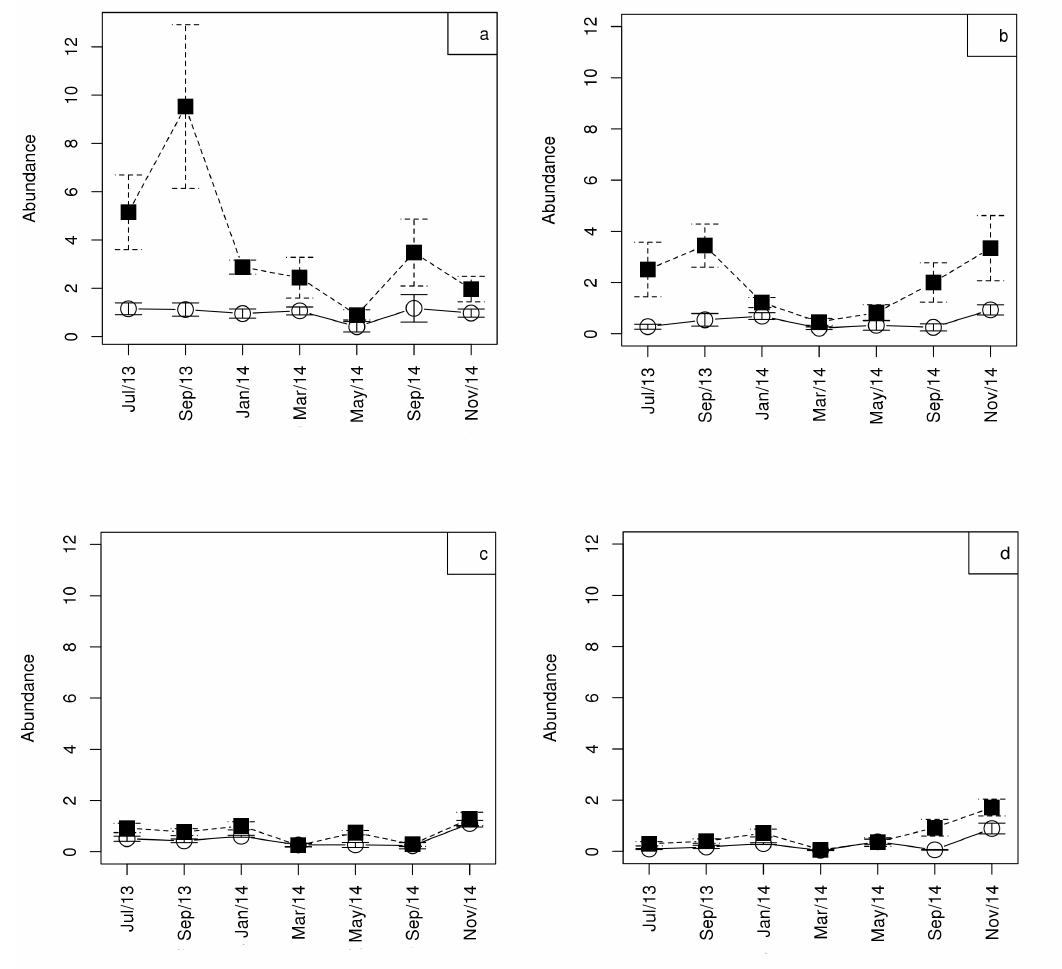
Figure 7. Average abundance of Calanoida copepodids ( a ), Cyclopoida copepodids ( b ), Calanoida nauplii ( c ) and Cyclopoida nauplii ( d ) (vertical bars: standard error) per month sampled ( ○ = central compartment, ■ = lateral compartment) of the reservoir Barragem da Pedra, Jequié,